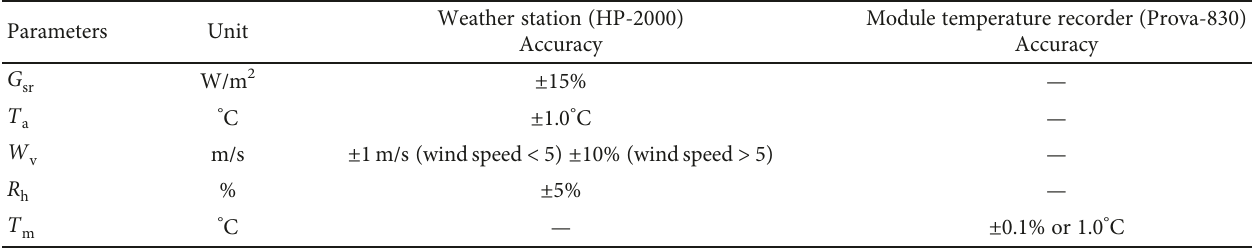
Table 3: Accuracy of equipment used in this